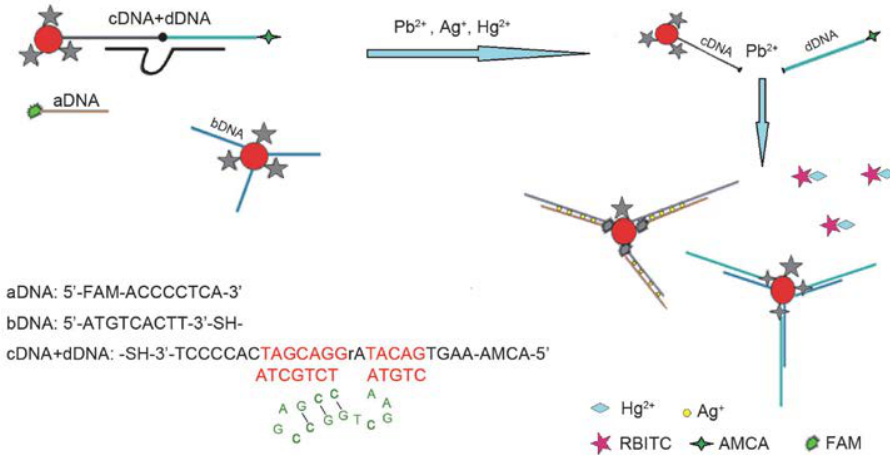
Fig. 1. Schematic of simultaneous detection of Ag + , Hg 2+ , and Pb 2+ using AuNP-based fluorescent sensors.